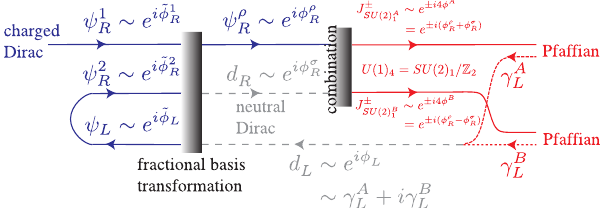
FIG. 16. Schematics of splitting a chiral Dirac channel into a pair of Pfaffian